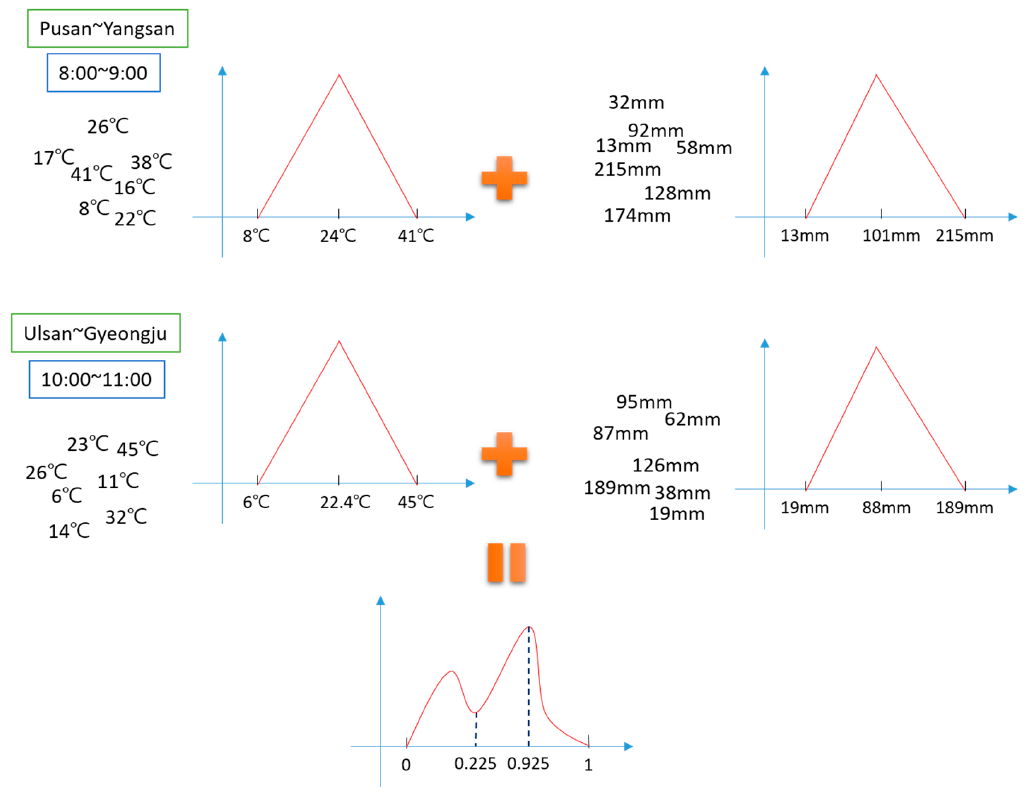
Figure 2. Example of Fuzzy C-means (FCM) according to the temperature and amount of rainfall on the roads.